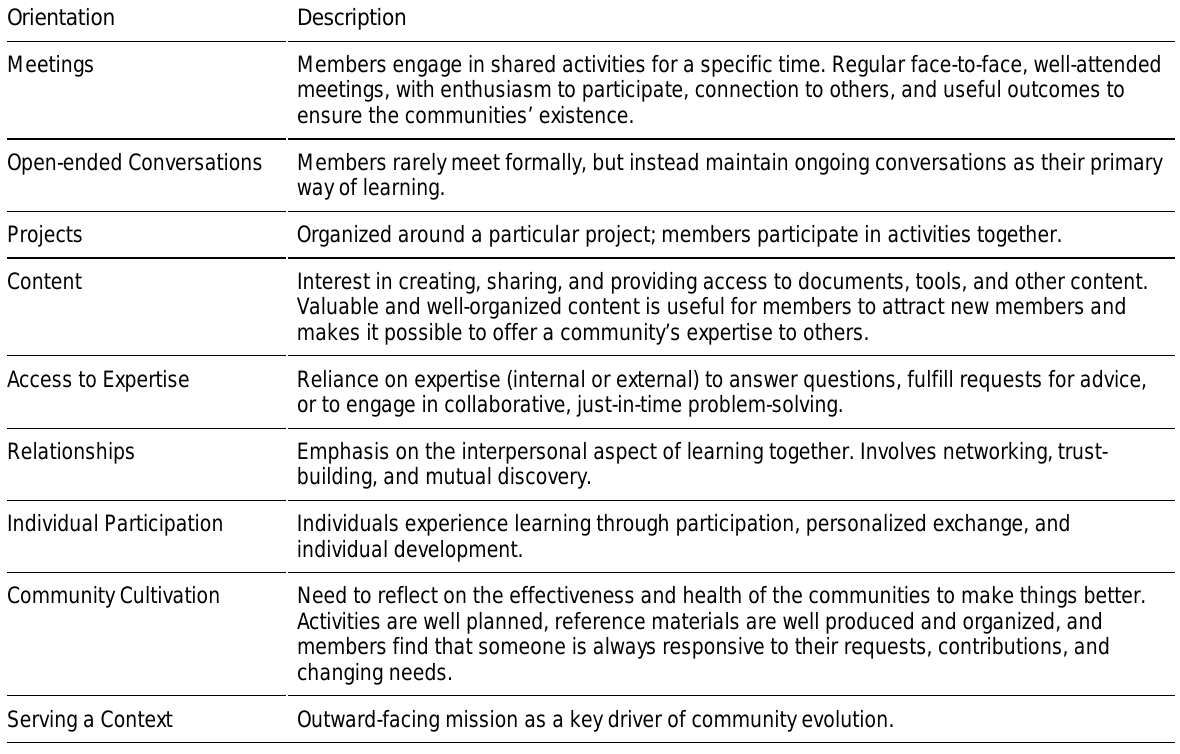
Table 1. Orientations of Communities of